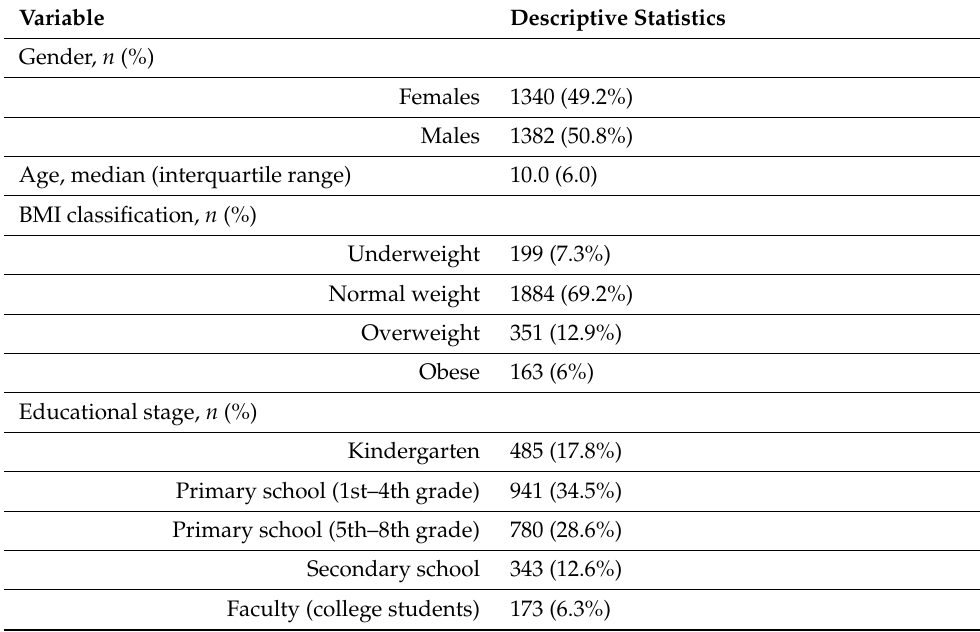
Table 1. Basic characteristics of the study